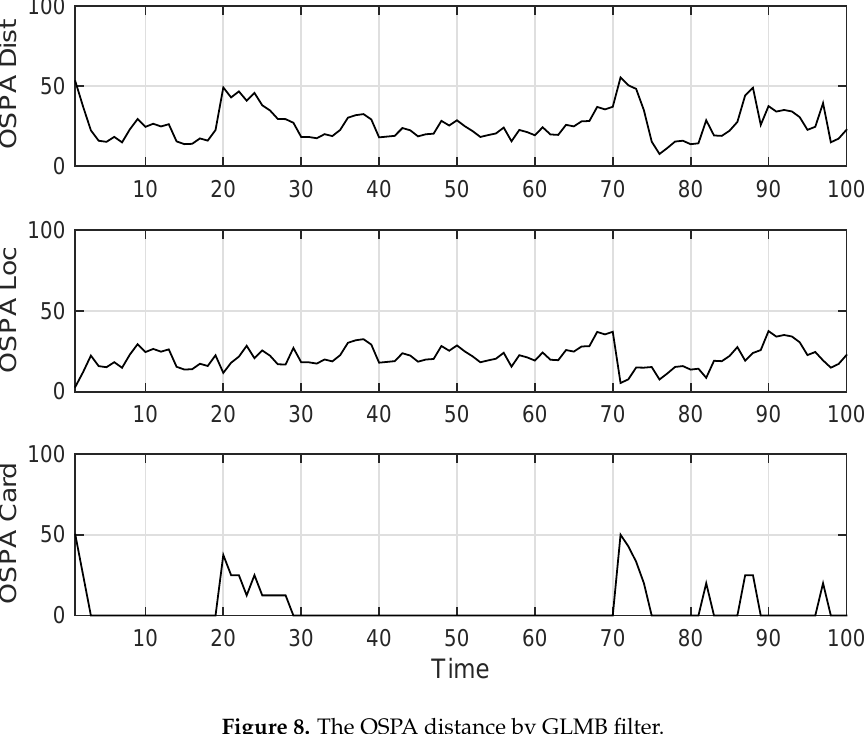
Figure 8. The OSPA distance by GLMB filter.